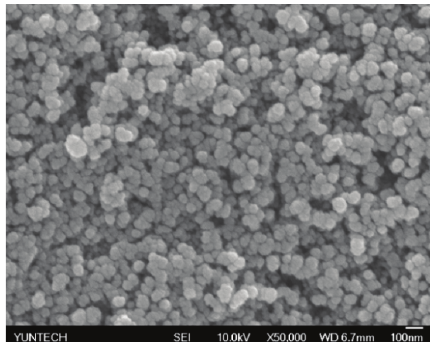
Figure 2: SEM images of graphene/TiO 2 composite film.